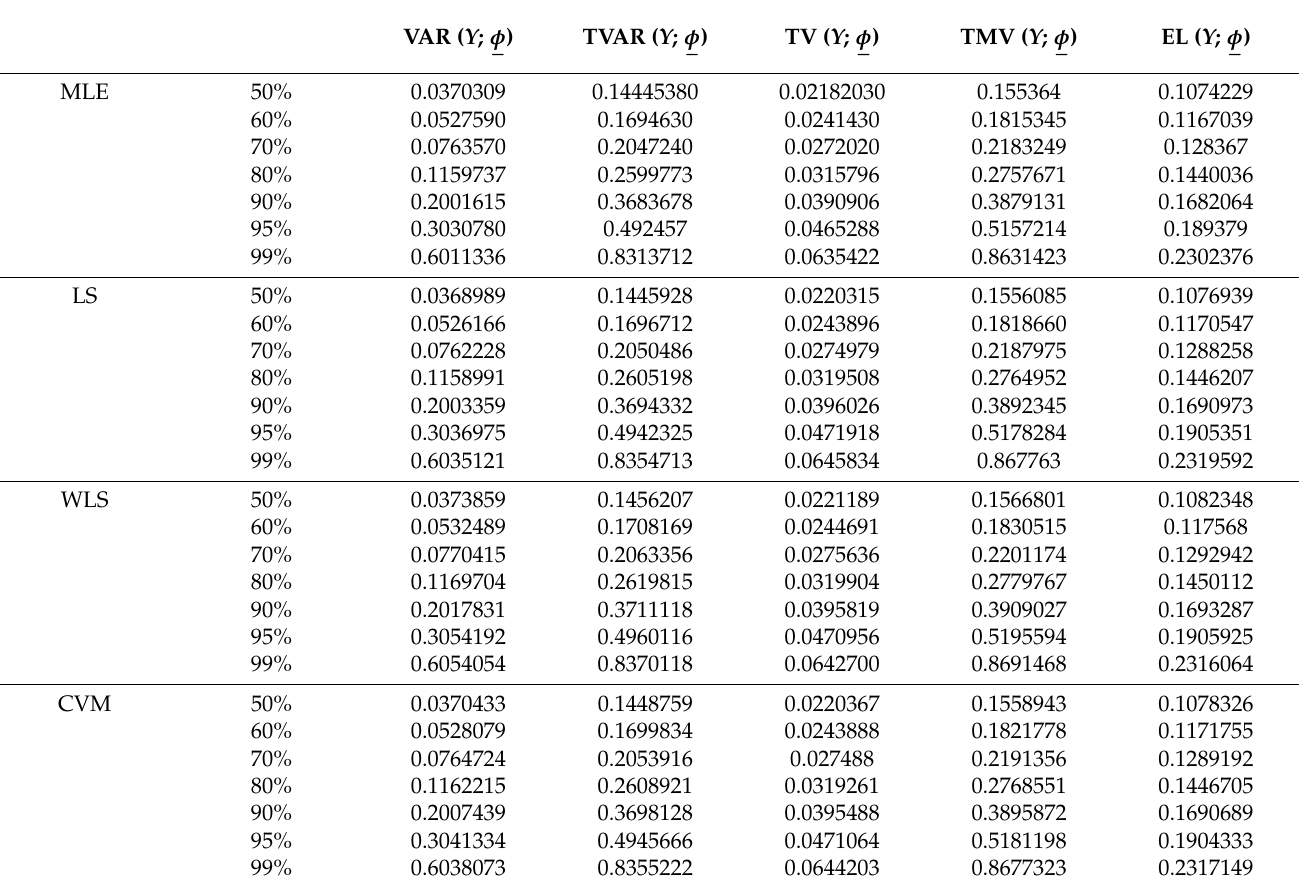
Table 10. The KRIs for the GRR-RW under artificial data where n = 100.